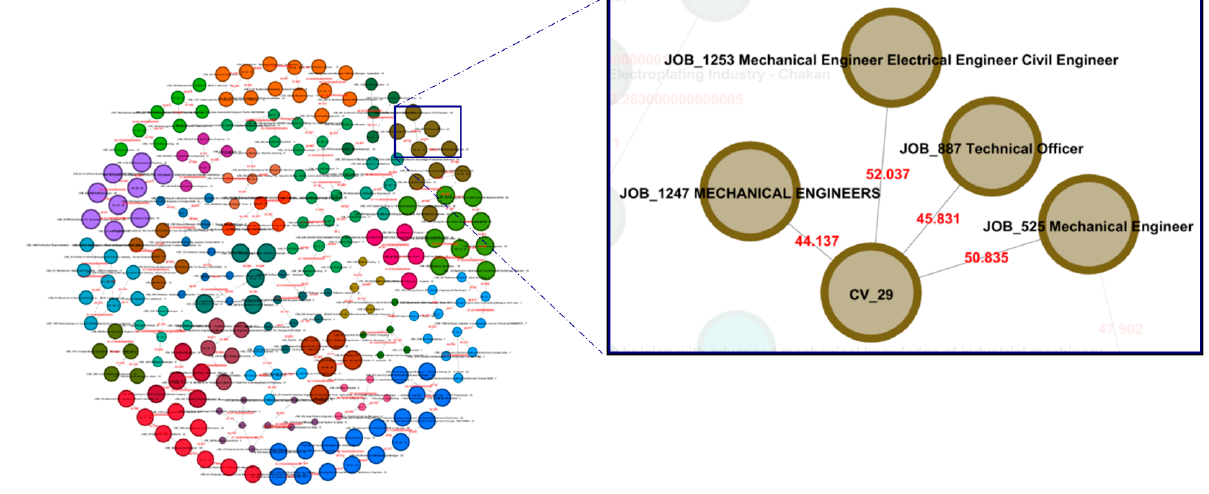
Figure 8. Direct relations between user profiles and relevant job postings. Each relation is defined based on the similarity score between the two nodes.